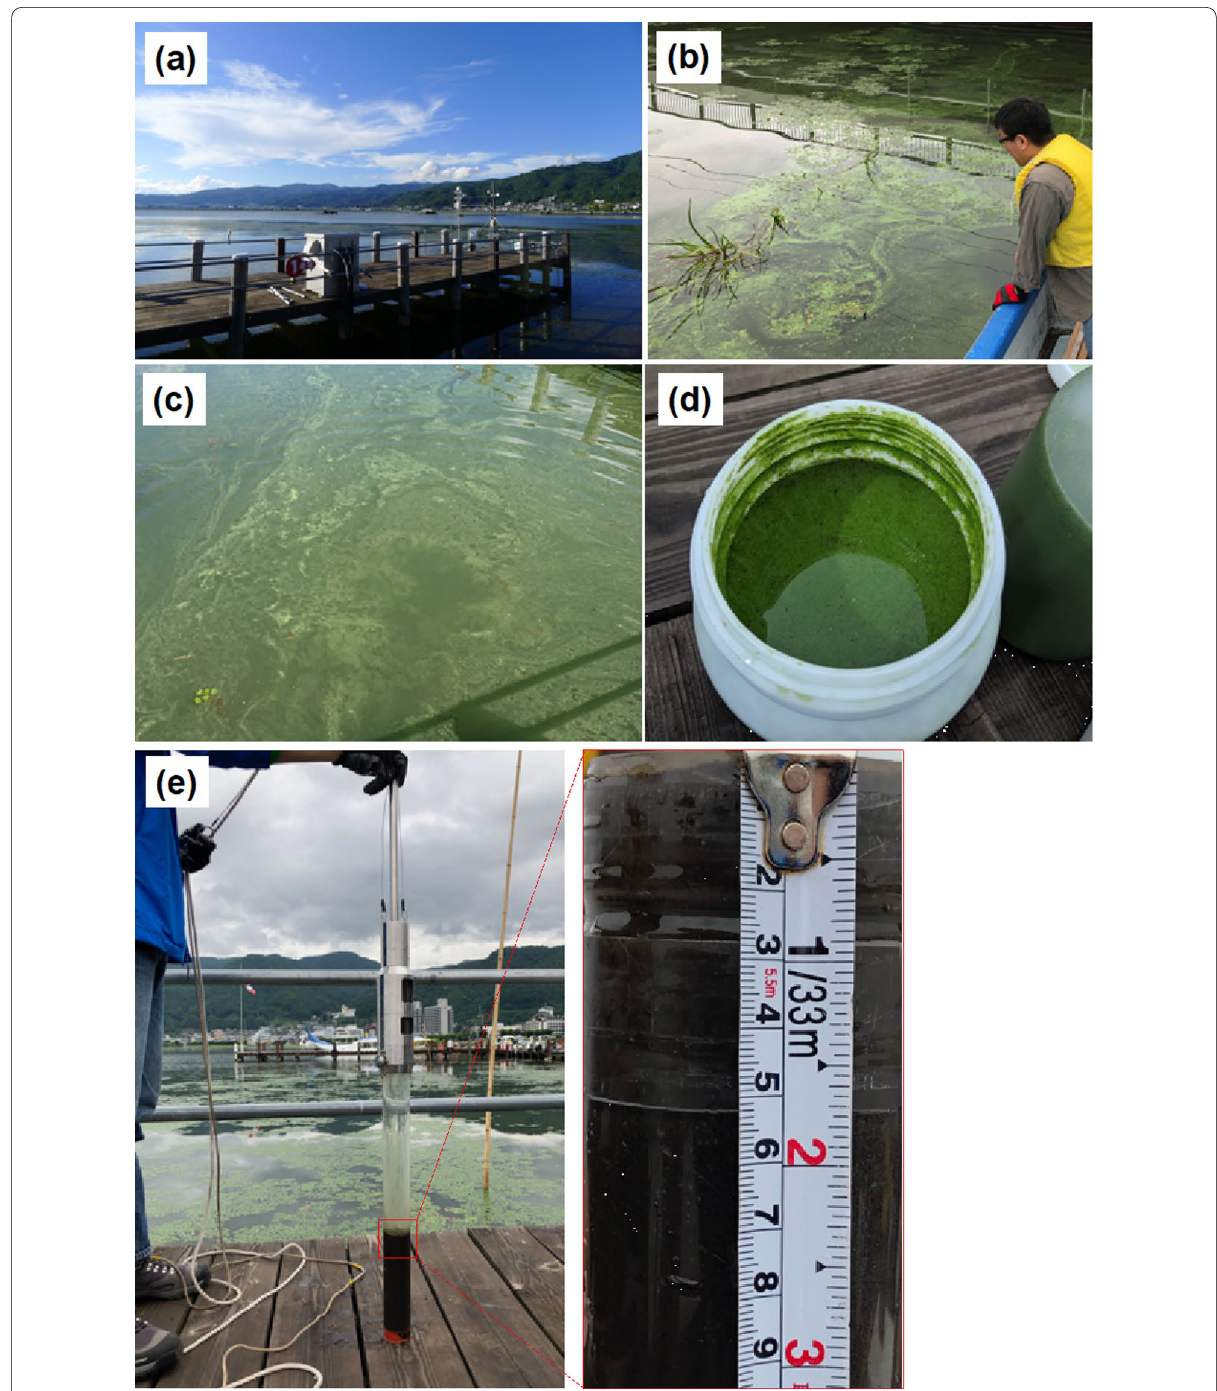
Fig. 2 Photographs of the sampling site and samples in June 2019. a Sampling site in the present study. The pier extends ~ 40 m from the lakeshore and attains a depth of ~ 1.8 m. b , c Floating cyanobacteria near the sampling site. d Planktonic cyanobacterial sample collected in a polypropylene bottle. e Sediment core collection with a gravity core